Question: What form of chart is displayed?
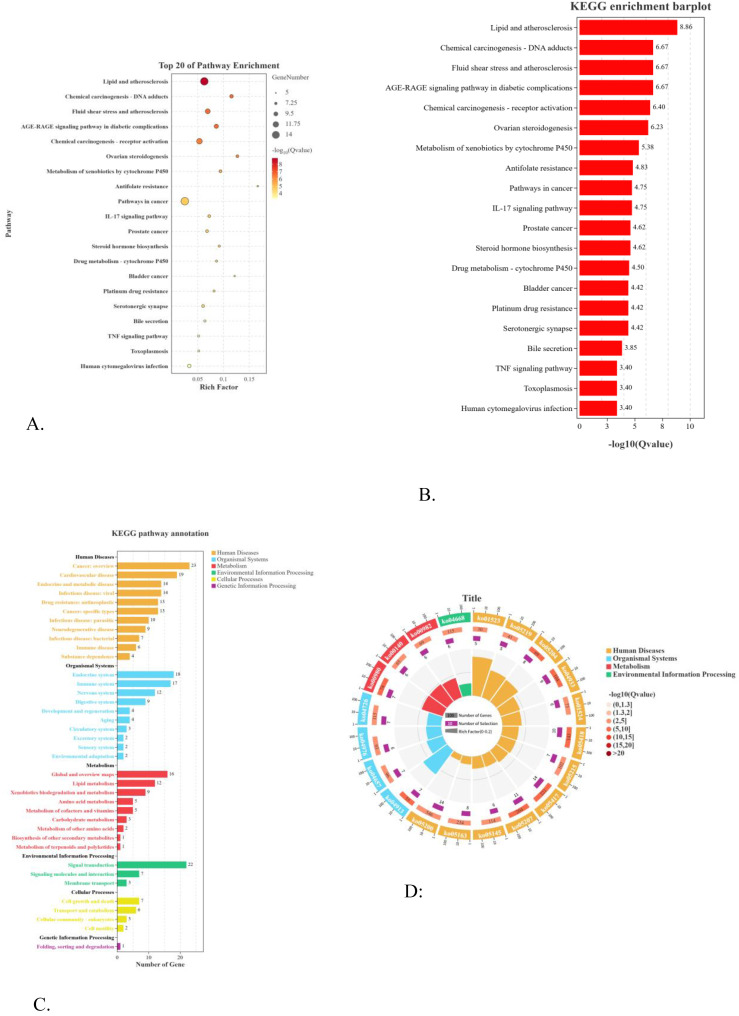
Answer: histogram